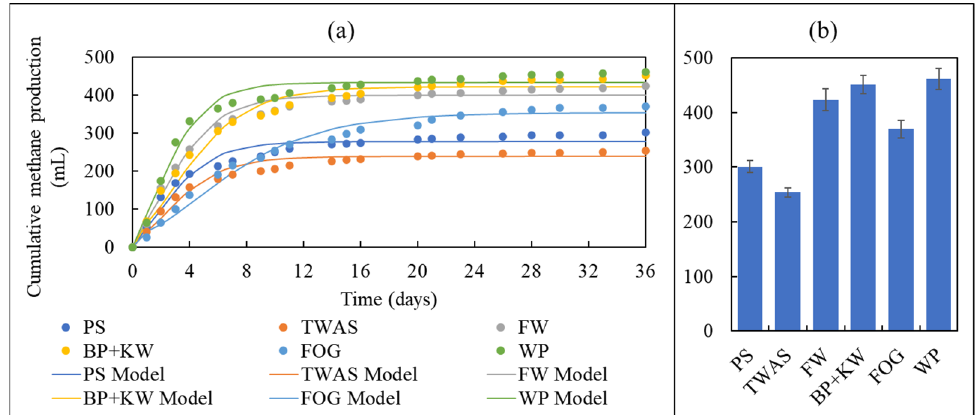
Figure 4. Plots of cumulative methane production of the different substrates. ( a ) Cumulative methane (mL CH 4 ) and Gompertz model fit, ( b ) ultimate methane (mL CH 4 ).